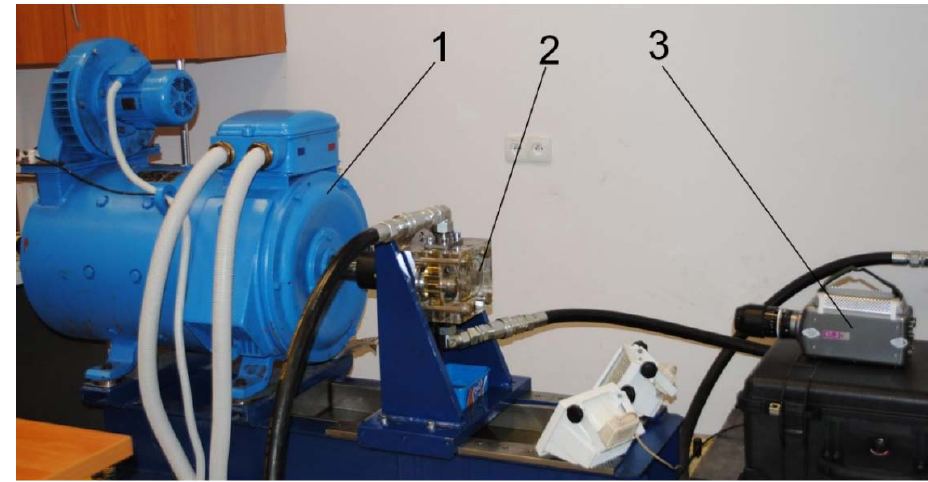
Figure 2. Experimental pump [18]